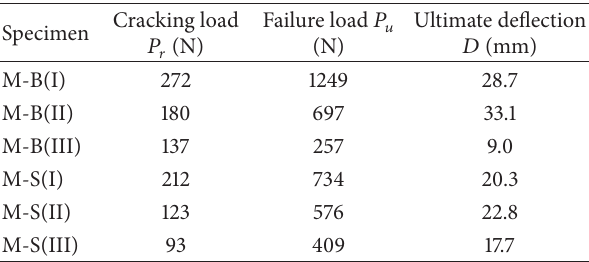
Table 3: The results of bending test.